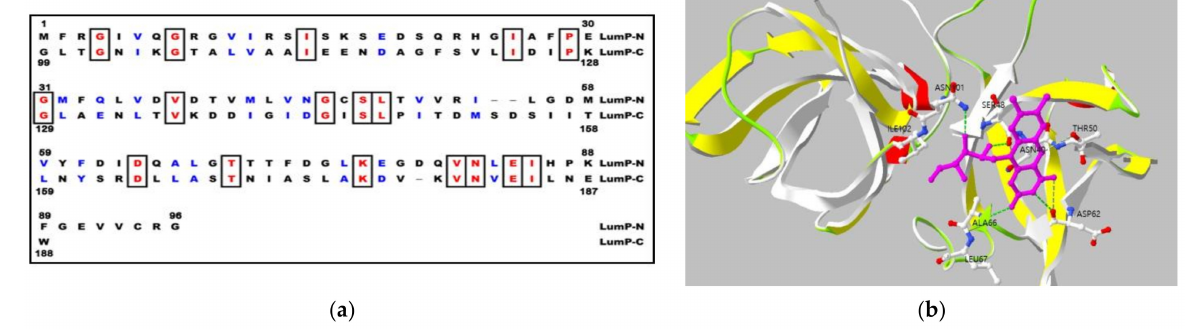
Figure 3. ( a ) Internal amino acid sequences between N-terminal domain half (LumP-N) and C-terminal domain half (LumP-C) of lumazine protein from P. leiognathi 741. Identical amino acids are marked in box and similar amino acids shown in blue letters; ( b ) Model of binding site topology of lumazine protein.